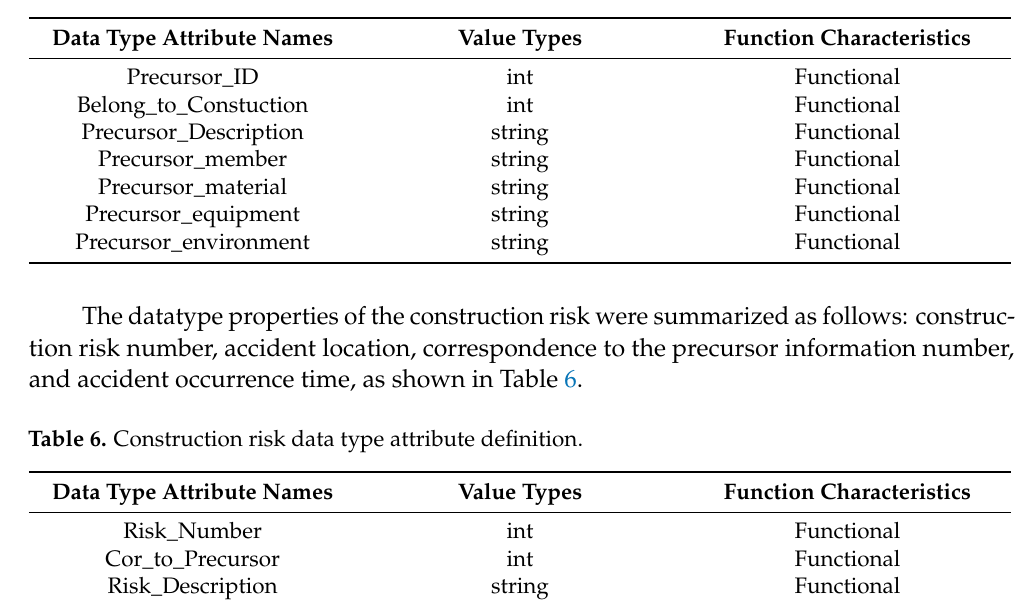
Table 5. Precursor information data type attribute definition.